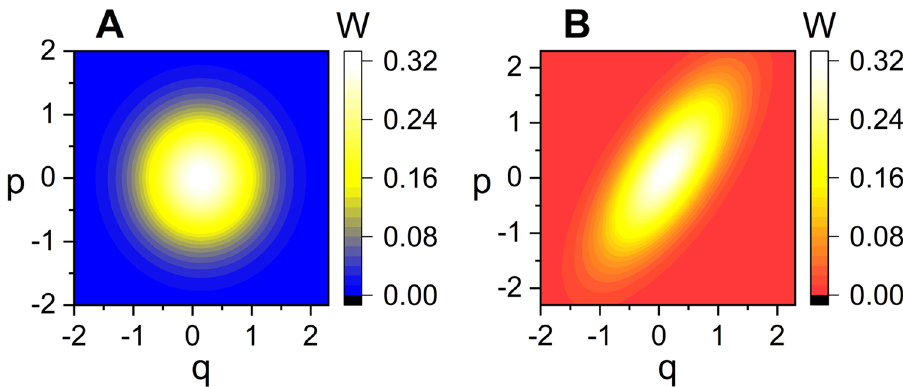
0 where ( c 1 , c 2 ) =